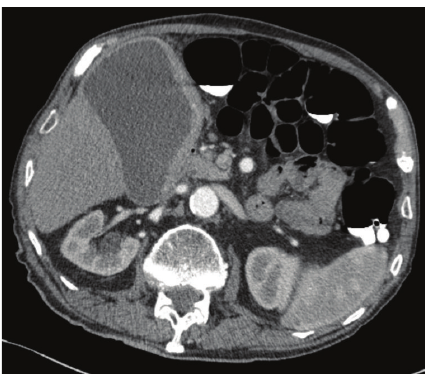
Figure 1: Computerised tomography colonography demonstrating a grossly distended gallbladder with a thickened medial wall mea- suring up to 1cm.